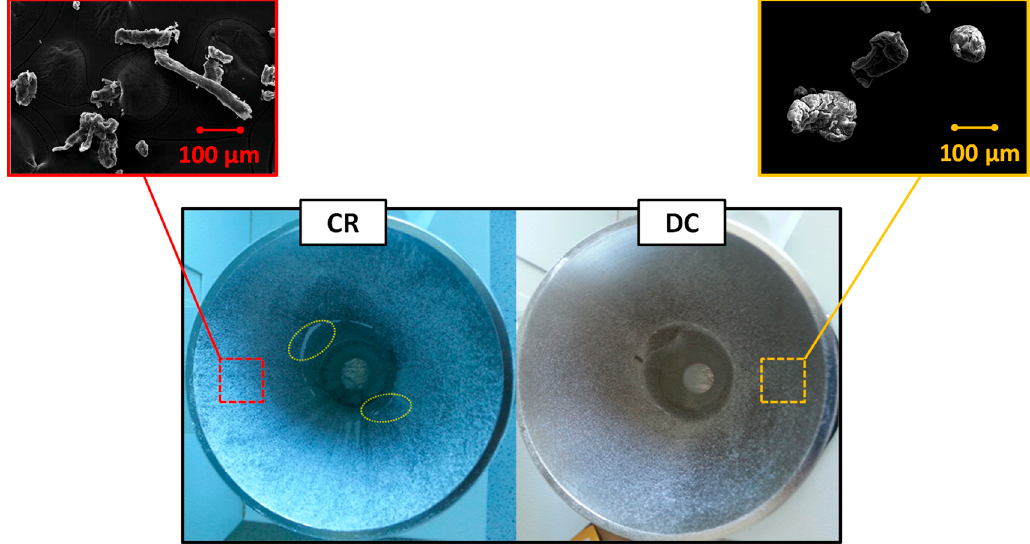
Figure 3. Stainless steel container post flow rate analysis. Square inserts are SEM images of the recovered pure polymer powders. Circular lines on the CR funnel image show the accumulation of powder at the funnel bend, which was not observed for the DC samples. Note: These are just for the pure polymers.